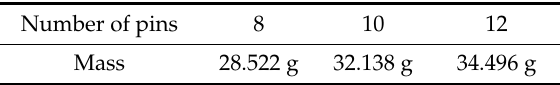
Table 4. The masses of 3 prototypes of CTSA-II hand.